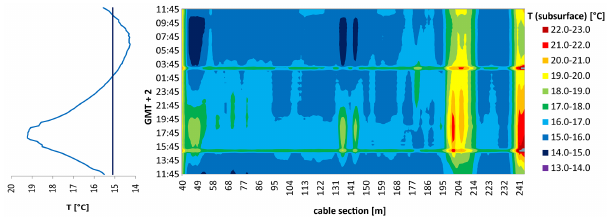
Figure 9. Surface water (light blue) and groundwater (dark blue) temperature (line diagram, left side) and streambed temperatures (colour plot, right side) in the Chriesbach streambed at about 0.4m depth, as measured with a fibre-optic cable installed after river restoration on 3–4 July 2014. The x axis of the colour plot shows the section of the fibre-optic cable in metres; the colours represent the streambed temperatures in ◦ C. Thereby, each coloured line on the x axis, from cable section 40 to 243m, represents one measure- ment. The y axis states the time of the measurements.